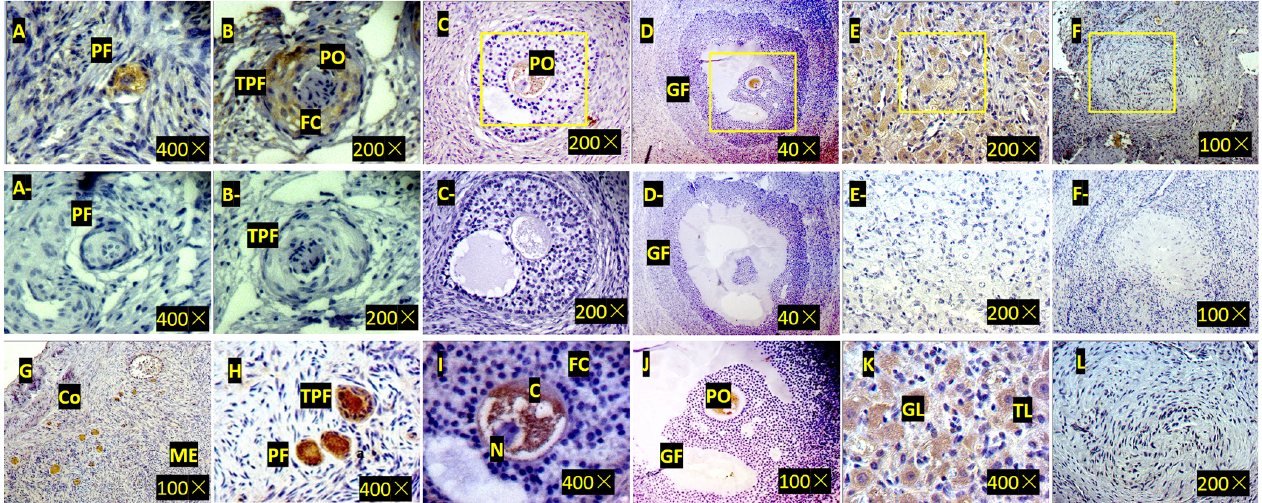
Figure 3. Expression of ZNF33B in bovine ovary (a–l) . (a) Expression of ZNF33B in primordial follicle tissue. PF is the primordial follicle. (b) Expression of ZNF33B in primary follicle tissue. TPF indicates primary follicles, PO indicates primary oocytes, and FC indicates follicular cells. (c) Expression of ZNF33B in secondary follicle tissue. (d) Expression of ZNF33B in mature follicle tissue. GF indicates mature follicles. (e) Expression of ZNF33B in corpus luteum. (f) Expression of ZNF33B in corpus albicans. A negative control chart is shown for panels (a–f) . (g) Expression of ZNF33B in the ovarian cortex. Co is the ovarian cortex, and ME is the ovarian medulla. (h–l) Enlarged picture of the indicated part of (g) and (c–f) . N is nucleus, C is cytoplasm, FC is follicular cells, GL is granulosa luteal cells, and TL is membrane luteal cells. Bar: 20µm.